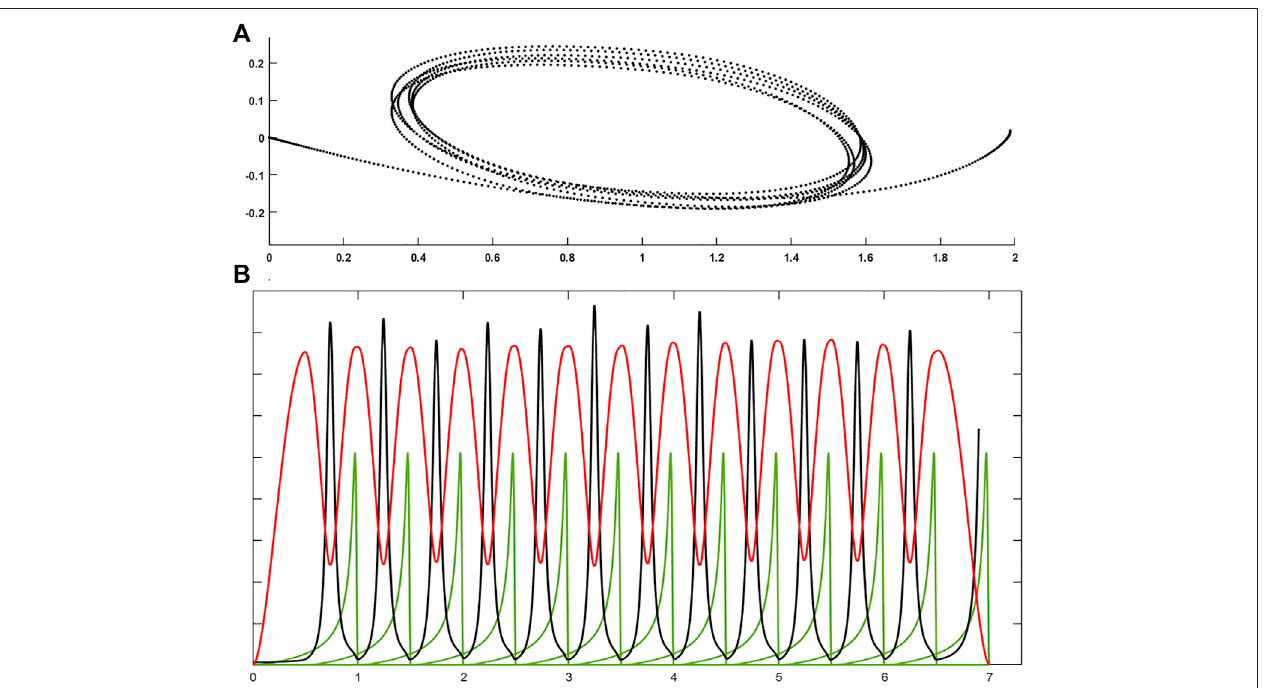
FIGURE 3 | (A) : Example of a generic trajectory with multiple VPs generated by the PMP model by chaining a sequence of PTP movements with time overlap between consecutive Γ -functions; the trajectory ischaracterized by 13 targets and 12 VPs; the Γ -functions ofsuccessivecommands have a 50% time overlap. (B) : time course ofspeed(red), curvature(black)pro fi les,andthe13 Γ -functions(green). Each Γ -functionhasadurationof1 s,witha50%overlap betweensuccessivefunctions.